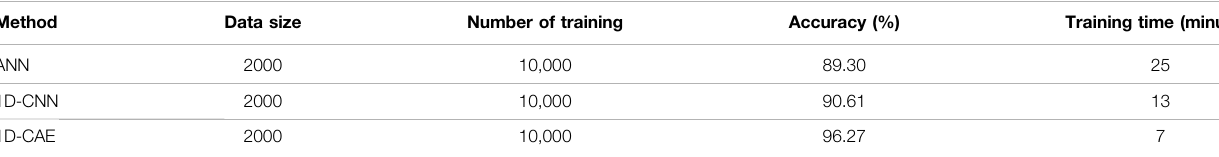
TABLE 2 | Comparison of different deep learning network models.